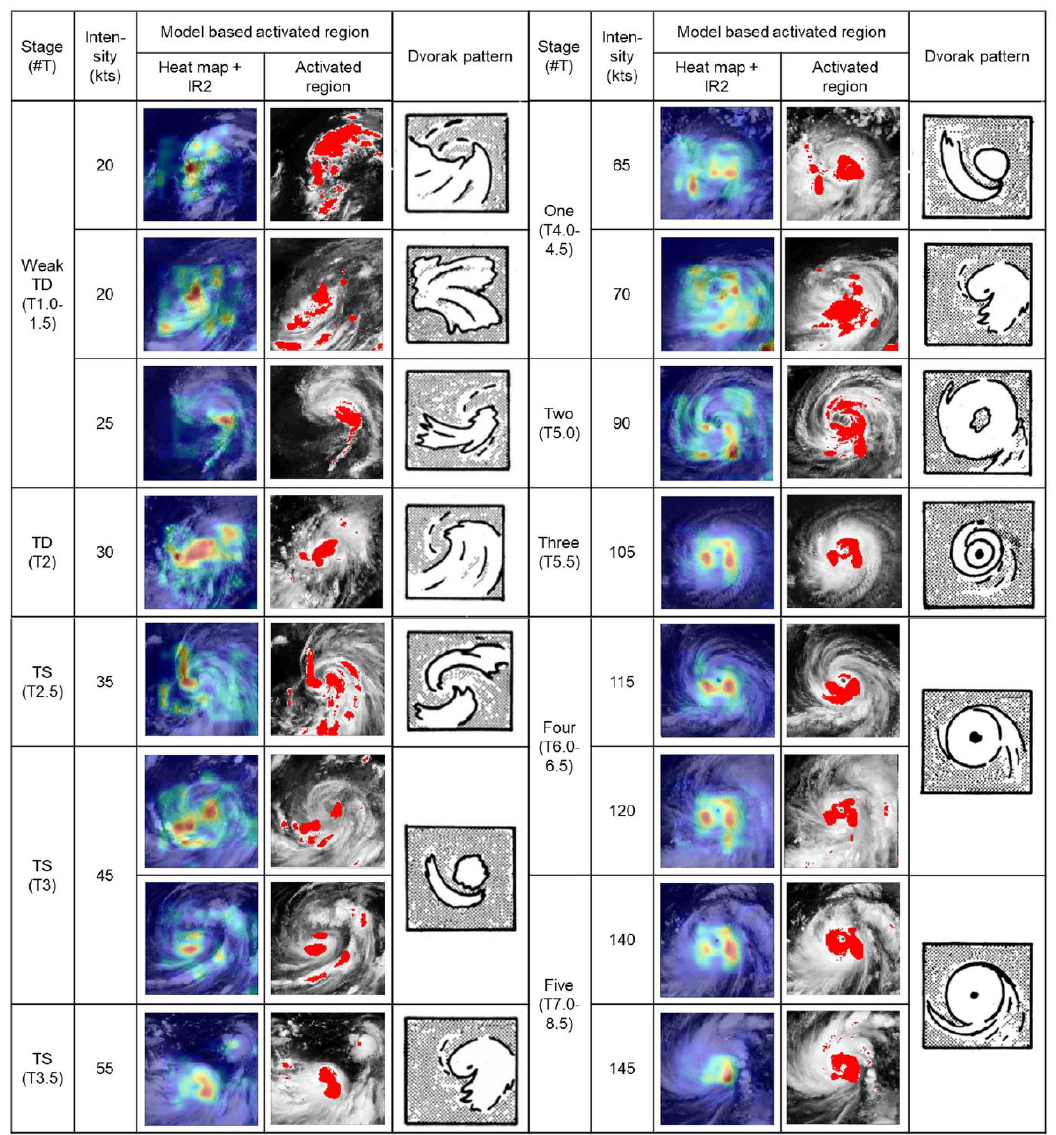
Figure 11. Matching between the Dvorak technique-based TC patterns [57] and the CNN model-based activated regions according to TC categories. The “3d2” model-based activated region in the IR2 channel is marked in red. The 1 st column shows heat maps with the IR2 channel and the most significant region is extracted using the upper 3% of the heat map values. It is marked as the red region in the 2 nd column. The 3 rd column shows the TC patterns of each categorical TC used in the Dvorak technique.